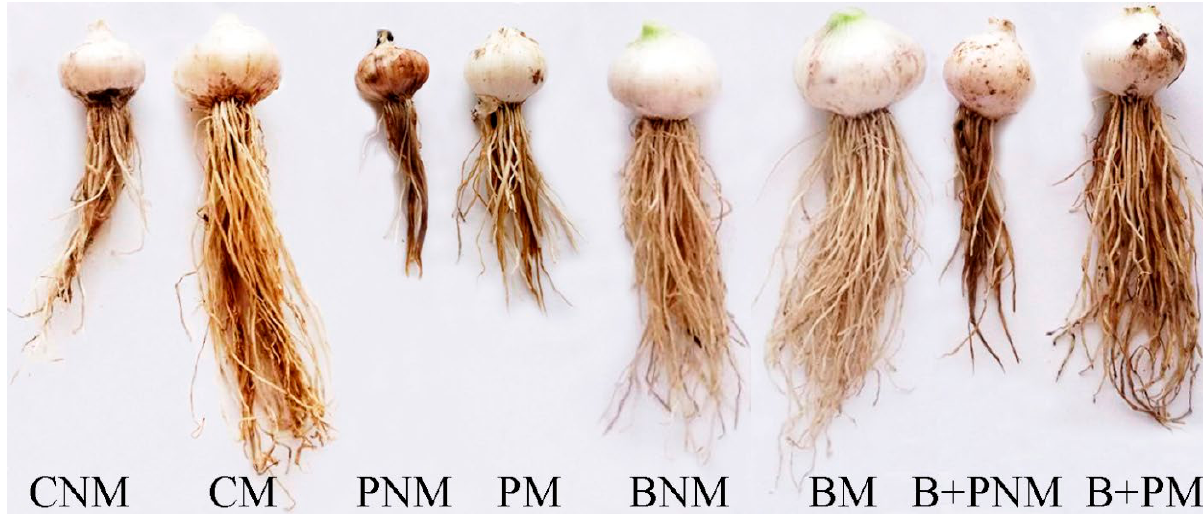
Figure 4. Photograph showing effects of different treatments on resulting bulbs of garlic plants. The treatments were: CNM = untreated control, CM = treated with AMF, PNM = inoculated with Sclerotium cepivorum , PM = inoculated with S. cepivorum and treated with AMF, BNM = treated with Bacillus amyloliquefaciens GGA, BM = treated with B. amyloliquefaciens GGA and AMF, PBNM = inoculated with S. cepivorum and treated with B. amyloliquefaciens GGA, and PBM = inoculated with S. cepivorum and treated with B. amyloliquefaciens GGA and